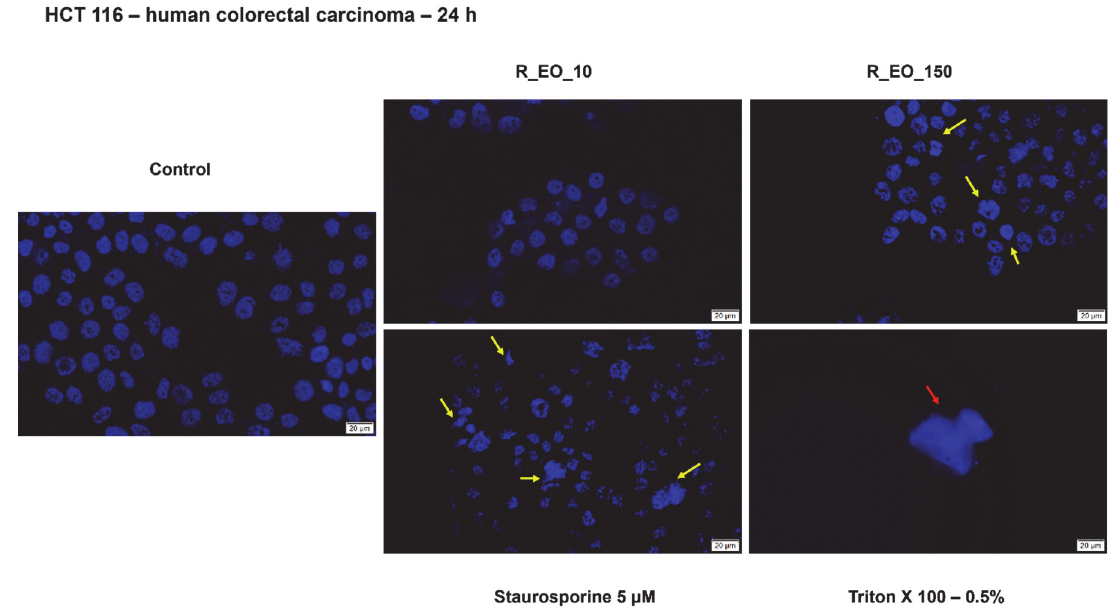
Figure 8. Colorectal cancer cells—HCT 116 nuclei stained with Hoechst 33342 dye after a 24 h treatment with Rosmarinus officinalis L. essential oil—R_EO (10 and 150 μ g/mL). Staurosporine (5 μ M) was used as the positive control for apoptotic changes at nuclear level and Triton X ‐ 100 (0.5%) for necrosis. The yellow arrows indicate signs of apoptosis, and the red arrow shows signs of necrosis. The scale bar was 20 μ m.